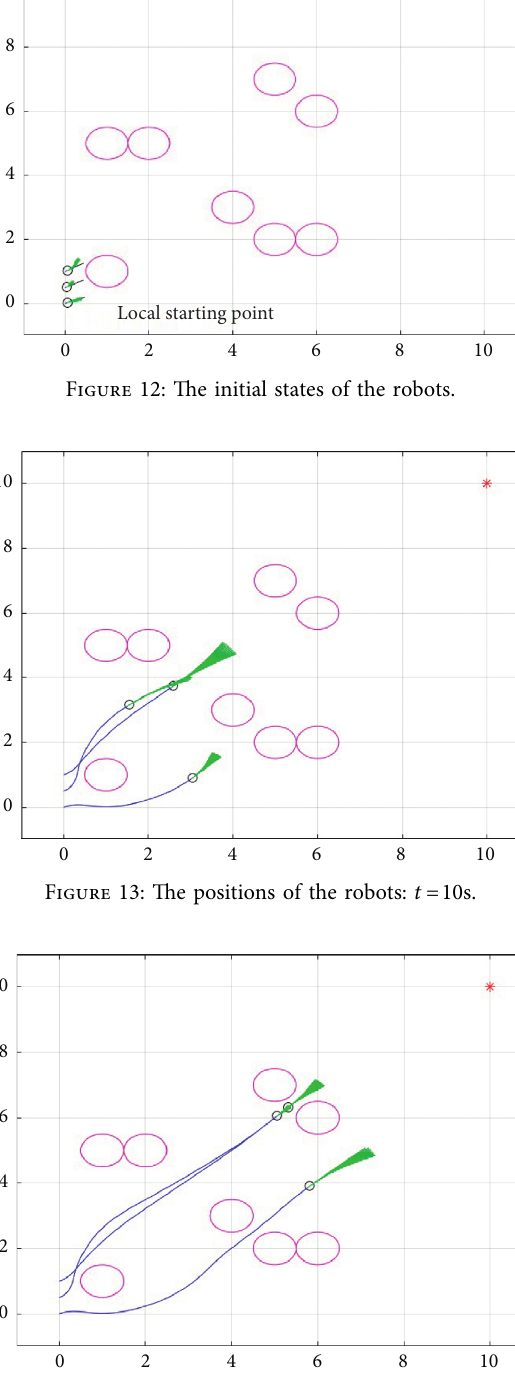
Figure 14: The positions of the robots: t � 15s.